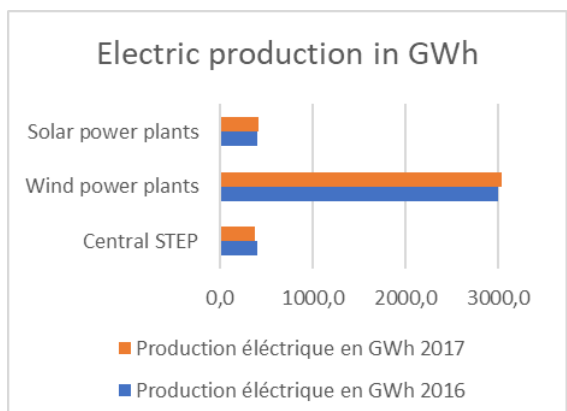
Figure 2. Electric production in GWh by ONE in Morocco (source